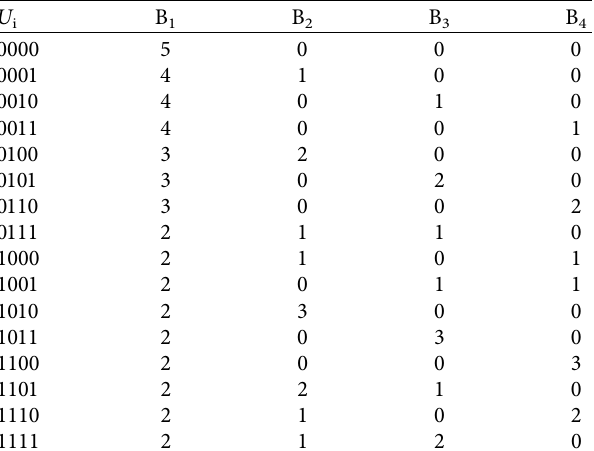
Table 1: Bit data coding